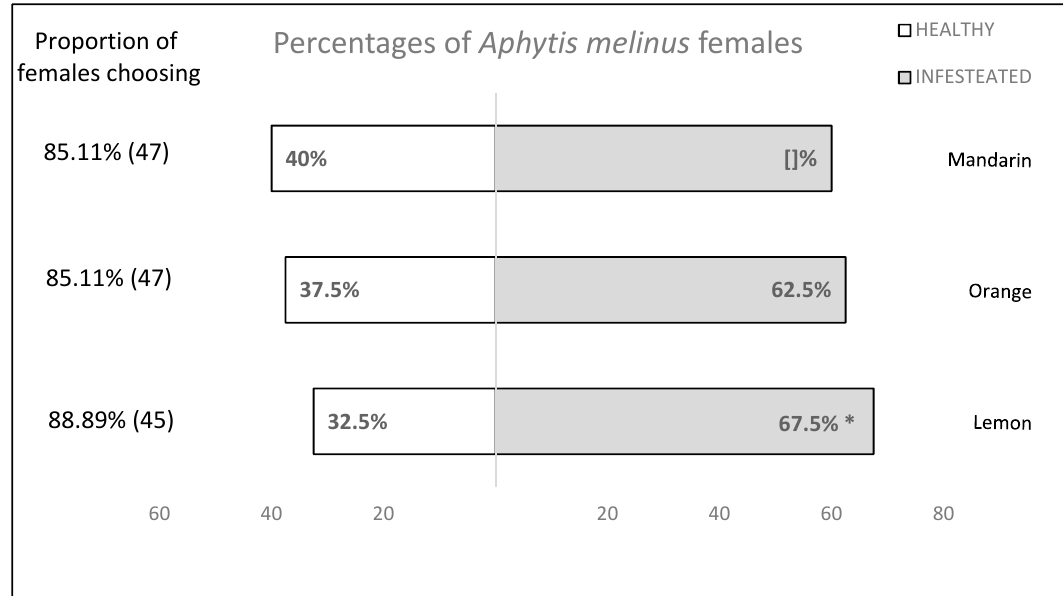
Figure 2. Attractiveness of Aonidiella aurantii -infested citrus fruit towards Aphytis melinus mated females. Two choice bioassays were conducted in a still air arena with citrus fruit, infested or not by California red scale, providing olfactory cues. Forty wasps were tested in each bioassay. For each test, asterisks indicate significant differences in the number of wasps choosing different cue ( χ 2 test with Yates correction, p < 0.05). To the left of the bars is the proportion of females that made a choice for one of the two odours, as well as the total number of females that were tested.